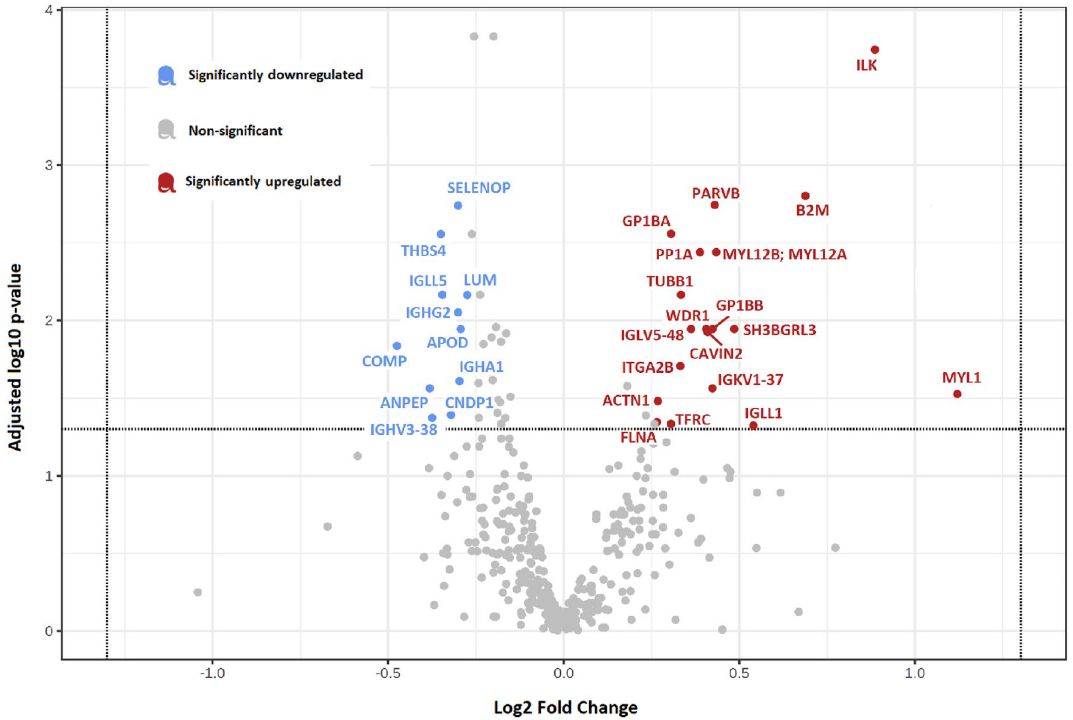
Figure 1. Proteomic footprint of significantly dysregulated proteins in POTS. Volcano plot illustrating 30 significantly dysregulated proteins in POTS. Eleven downregulated proteins in blue and 19 upregulated proteins in red. Complete names of proteins are found in Table